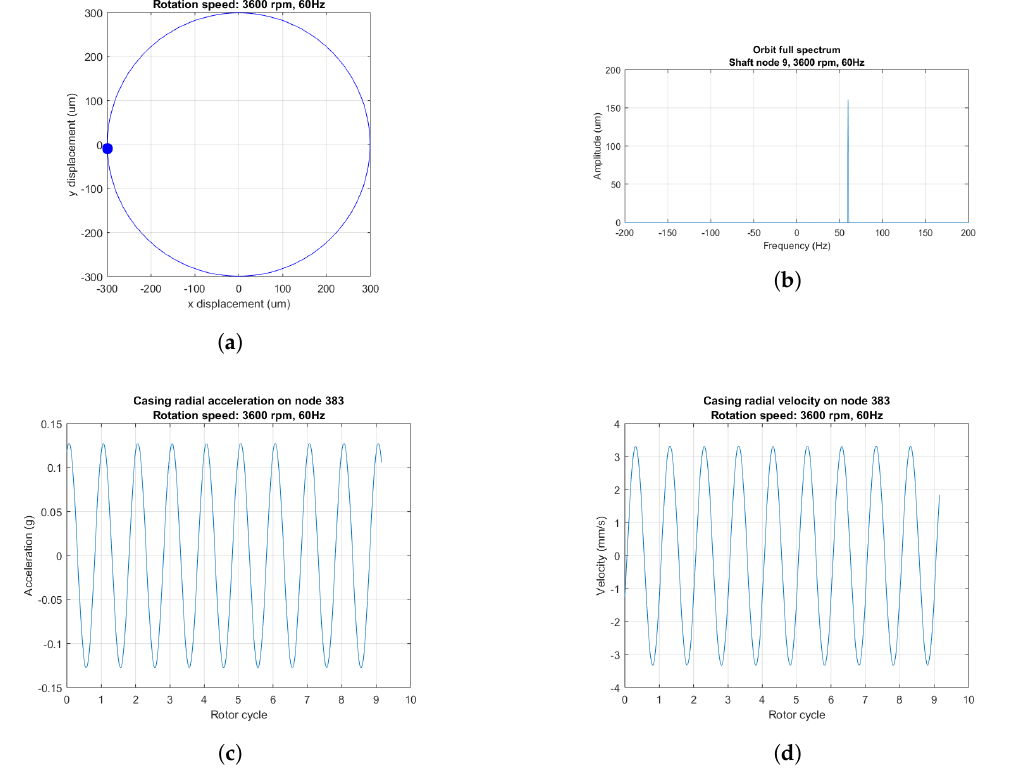
Figure 8. ( a ) Rotor orbit shaft displacement in the radial plane; ( b ) full spectrum of the rotor orbit; and ( c , d ) acceleration versus rotor cycle, i.e., versus time, and velocity versus rotor cycle—“acceleration time plot” and “velocity time plot”, respectively, hereafter—measured at selected casing node at 3600 rpm, with no rub and the shaft rotating in the anticlockwise